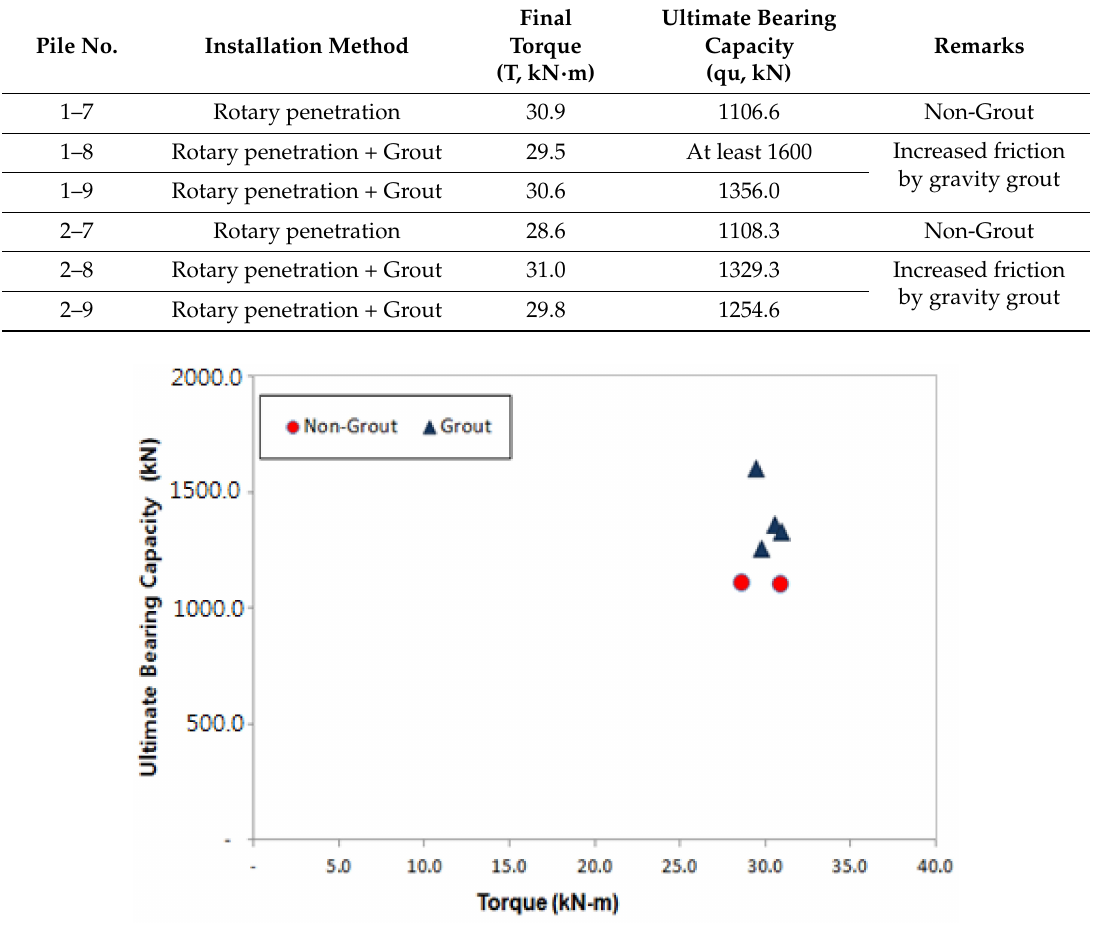
Figure 8. Torque (T)-ultimate bearing capacity